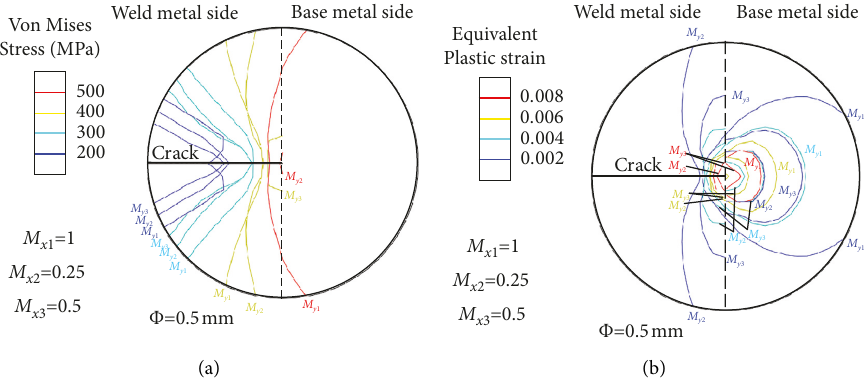
Figure 12: Contour of the sandwich structure welded joint model whose yield strength changes in the x -direction. (a) Von Mises stress contour at crack tip. (b) Equivalent plastic strain contour at crack tip.